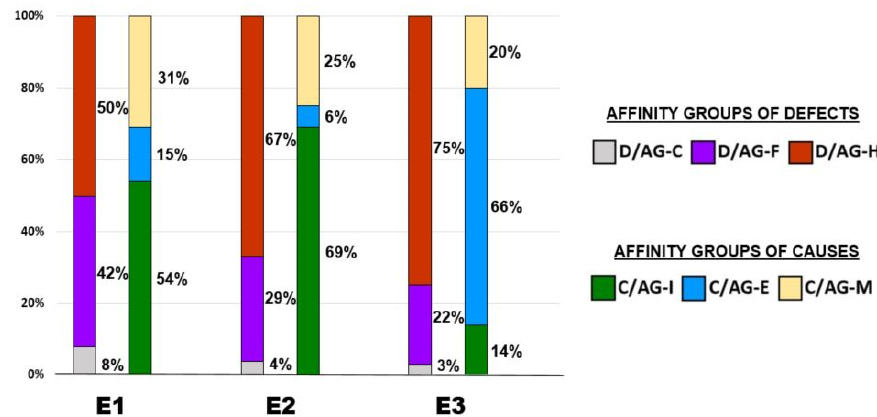
Figure 8. Percentage distribution of affinity groups by type of element.